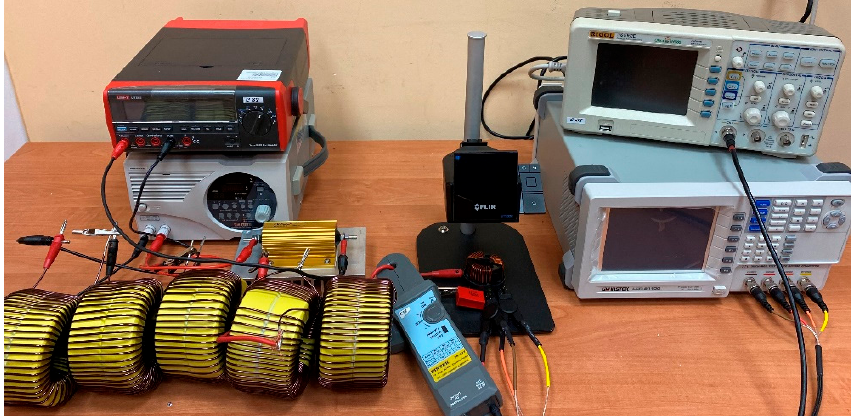
Figure 5. Photo of the setup for measuring the inductance of the inductor.